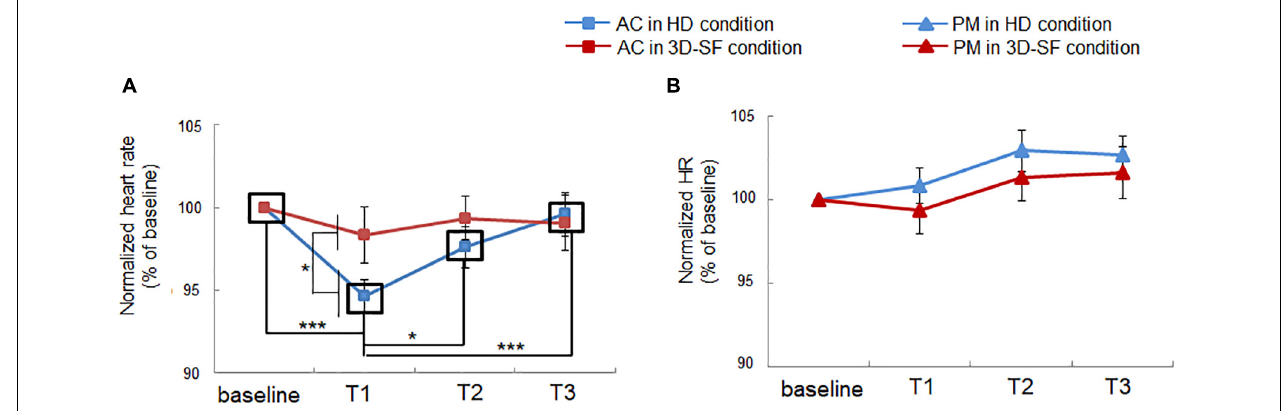
FIGURE 6 | Effect of music listening on normalized heart rate. (A) Comparison between the HD and 3D-SF conditions for AC. (B) Comparison between the HD and 3D-SF conditions when listening to PM.